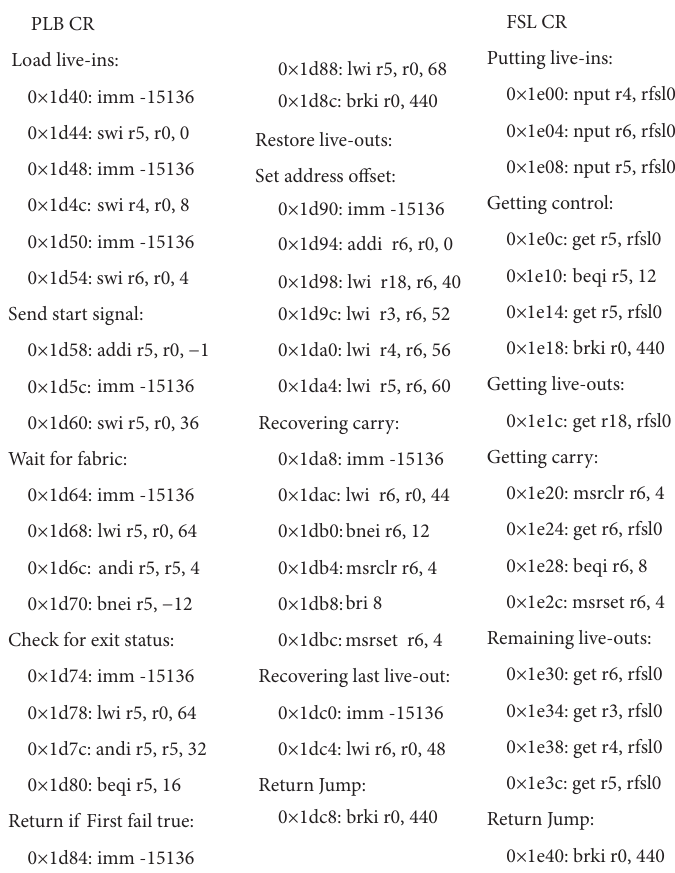
F 13: Comparison between PLB- and FSL-based CRs for the reverse